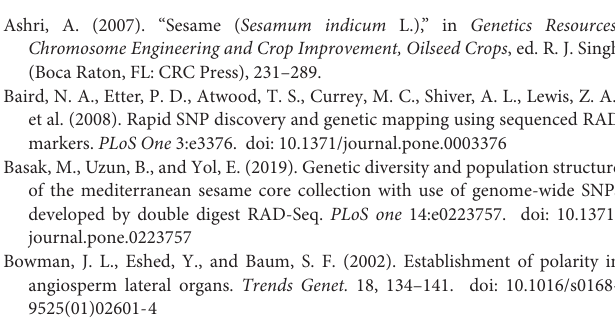
Supplementary Figure 1 | Total number of reads and GC content (%) for F 2 lines and two parents. Supplementary Figure 2 | (a,b) Amplification of developed InDel (S8_5062843) and CAPS (S8_4476867) markers with selected genotypes, respectively. NP, shattered capsule parent, KP, non-shattered capsule parent. N91, N143, N204, N182, N231, and N258 had shattered capsule phenotypes in F2. K28, K93, and